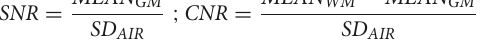
algorithm performance. Semi-automated methods of model validation may result in inflated and biased Dice